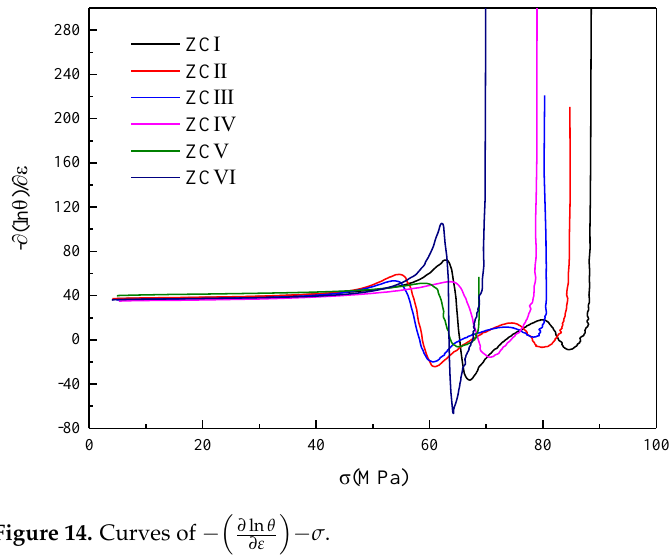
incremental work balance of the thermodynamic system. Figure 14 shows the results of the partial derivative calculation of the work-hardening rate curve. The critical conditions for dynamic recrystallization of the experimental alloy can be determined from the minimal values of the curves. Table 6 displays the data for the minima. As the number of (Mg, Zn) 12 Ce phases increases, the critical stress for dynamic recrystallization decreases and the corresponding critical strain decreases, indicating that the alloy is more likely to start dynamic recrystallization during thermal deformation.